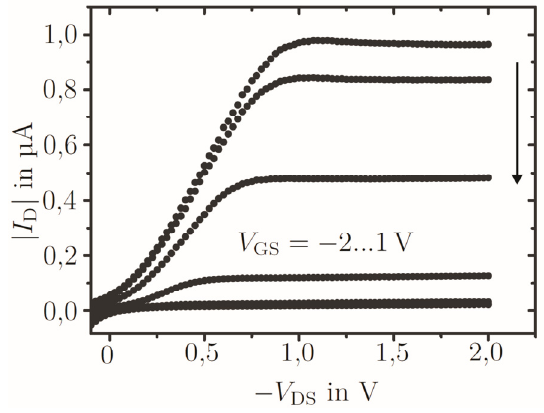
Figure 11. Output characteristics of an inverted staggered single particle TFT integrated by the SWEB technique with a Si nanoparticle (L = 70 nm, W = 800 µm and t ox = 30 nm). © 2015 IEEE. Reprinted, with permission, from